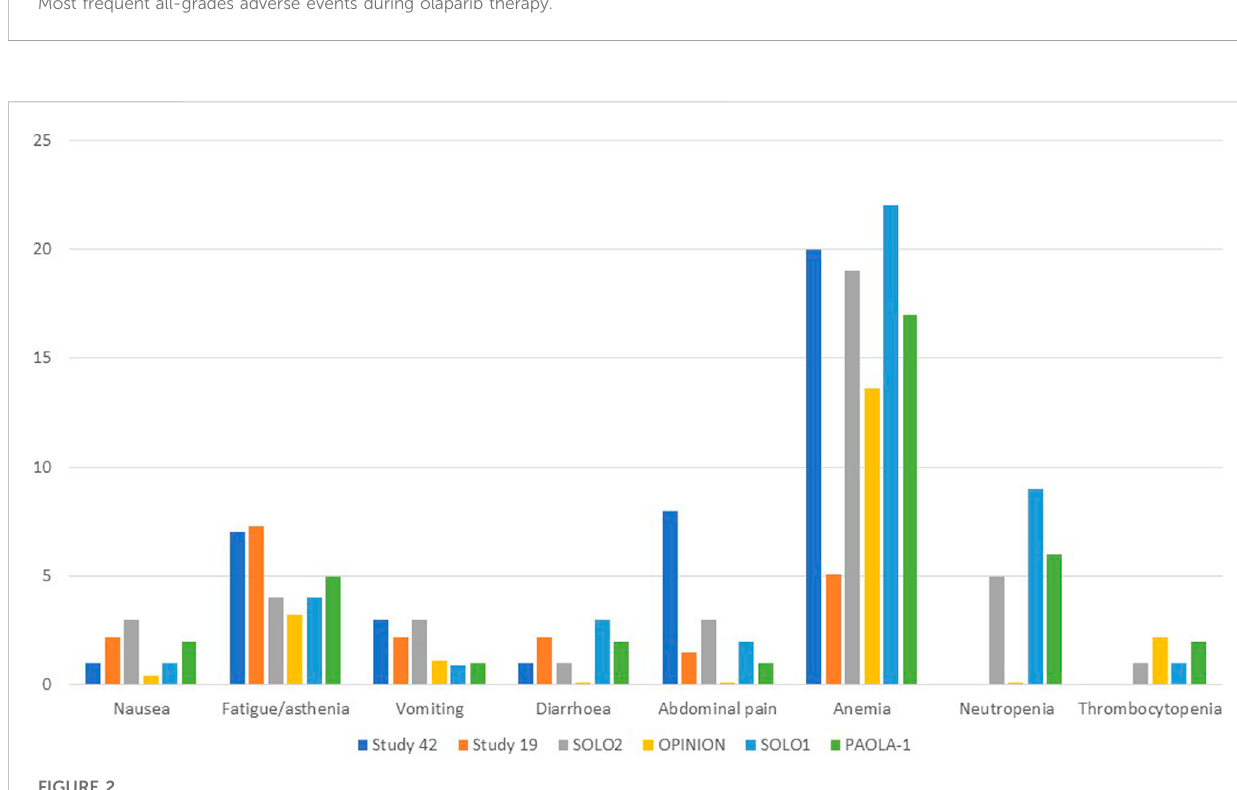
FIGURE 2 Most frequent ≥ G3 adverse events during olaparib